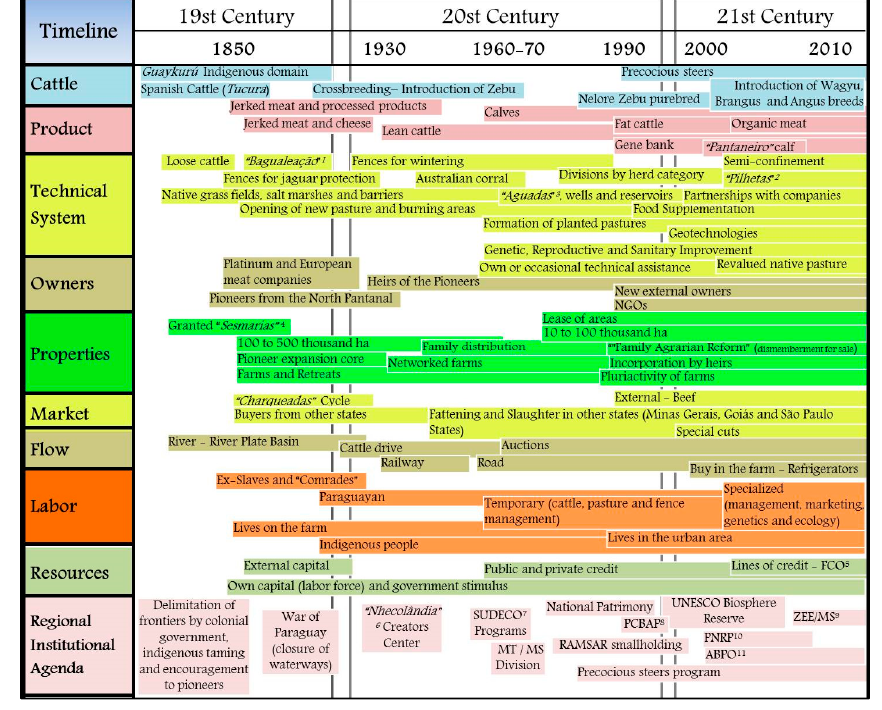
Figure 3. Timeline of cattle breeding in the South Pantanal. Note: 1 Capture of animals by bundling and sale of “lots” (groups of cattle). 2 Mobile tank with potable water for the herd, usually made of plastic. 3 Species of temporary lake, natural or artificial. 4 Distribution of land for agricultural production. 5 FCO: Central-West Funding Fund. 6 Pantanal sub-region in the municipality of Corumbá. 7 Central-West Development Superintendence. 8 Conservation Plan for the Alto Paraguai